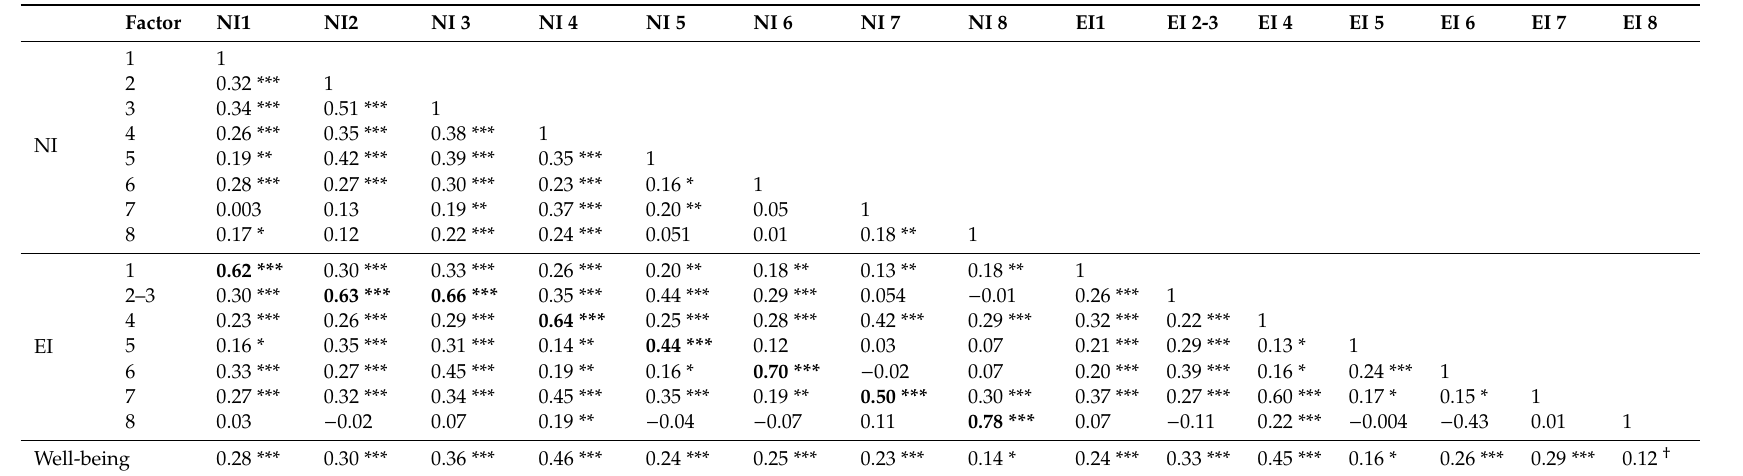
Table 4. Multi-trait-multi-method matrix ( N =